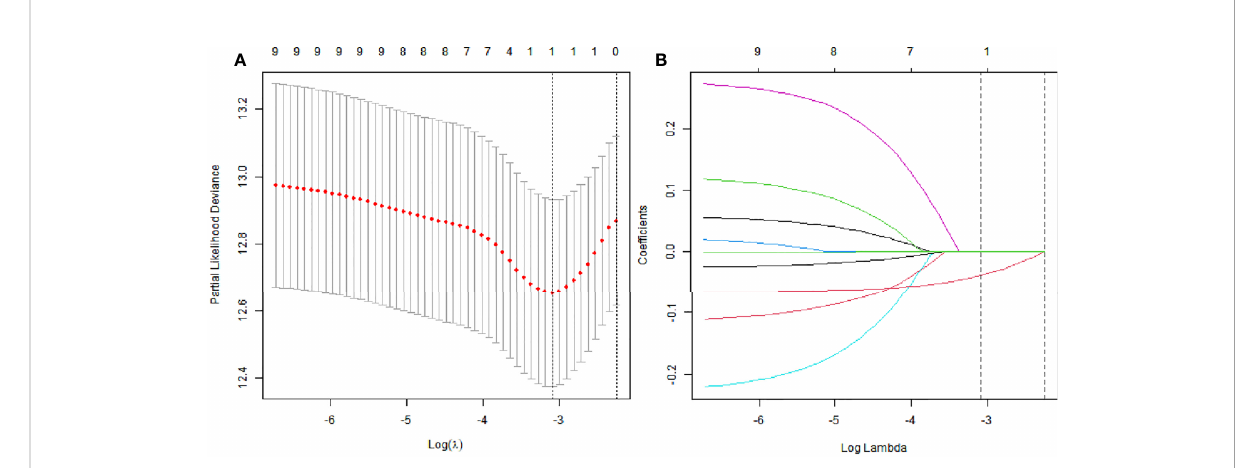
FIGURE 2 The least absolute shrinkage and selection operator (LASSO) analysis and risk score system were constructed. (A) The area under the ROC curve (AUC) was estimated with a cross-validation technique, and the largest lambda value was chosen when the cross-validation error was within one standard error of the minimum. (B) LASSO coef fi cient pro fi les of the eight factors.